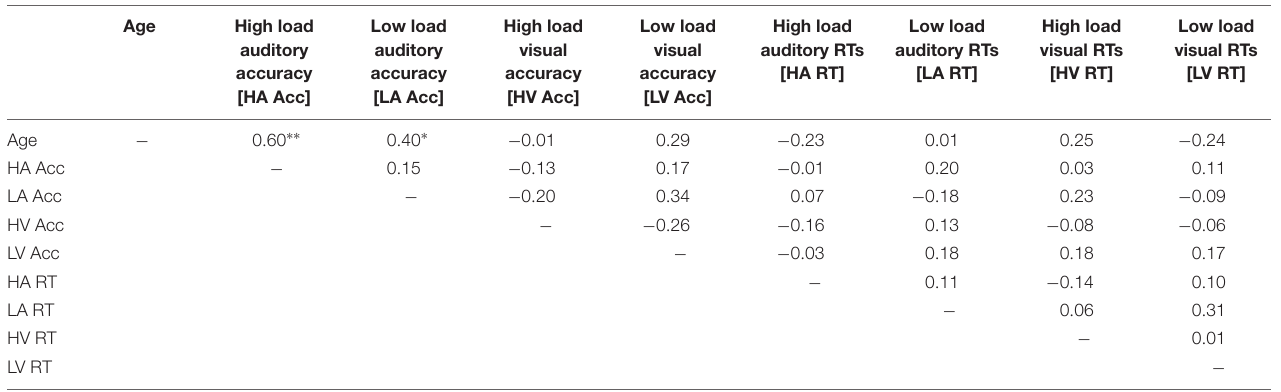
TABLE 3 | Spearman rho correlations between age, accuracy (difference scores), and response times (difference scores) across load and modality of distractor.